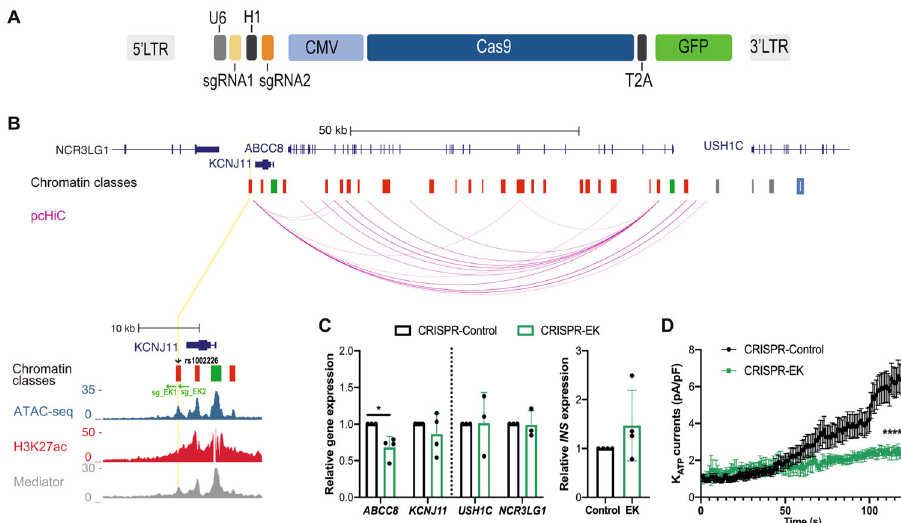
Fig. 4 CRISPR/Cas9 targeting of a non-coding variant in the ABCC8-KCNJ11 locus impairs ABCC8 expression and function in primary human islets. A Schematic of the lenti-construct used for simultaneous expression of two sgRNAs, Cas9 and GFP (12,021 bp) in primary human islets. B Genome Browser tracks of the genomic context in the KCNJ11-ABCC8 locus, arcs representing high-con fi dence pcHi-C interactions in human islets, highlighting variant rs1002226 (chr11:17405617) associated with diabetes risk (black arrowhead): This variant maps to a CTCF site (blue) on a class I active enhancer (yellow line, and zoomed inset); sg_EK1 and sg_EK2 fl anking rs1002226 (green arrows); Chromatin classes: active promoter (green); active enhancer (red); inactive enhancer (gray); inactive open chromatin (black); strong CTCF (blue). Accessible chromatin regions in human islets are shown by ATAC-seq, H3K27ac, and Mediator ChiP-seq. C ABCC8 mRNA is regulated by the rs1002226-containing enhancer in GFP + pseudoislet cells, CRISPR-EK (green), CRISPR-Control (Black) ( P = 0.0232; n = 4), while expression of KCNJ11 , control genes ( USH1C , NCR3LG1 ) in the same transcription activation domain, TAD ( n = 3) and insulin ( n = 4) were not modi fi ed. Data are presented as mean values + SD. D Measurement of K ATP currents in GFP + islet cells from CRISPR- EK ( n = 26 cells, 3 replicates) and CRISPR-Control ( n = 33, 3 replicates) ( P < 0.0001). Data are presented as mean values ± SEM. Two-tailed t tests were used to generate P -values. * P < 0.05, **** P < 0.0001. Source data are provided as a Source Data fi